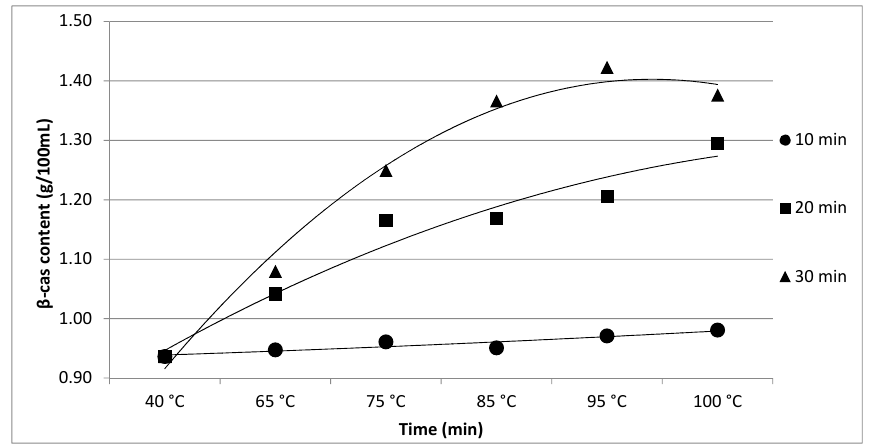
Figure 1. Effect of heating time and temperature on α -cas content. Equations: 10 min 0.0043x 2 + 0.0127x + 1.5763; R 2 = 0.9794), 20 min (y = 0.0031x 2 + 0.0373x + 1.5641; R 2 = 0.9733), 30 min (y =